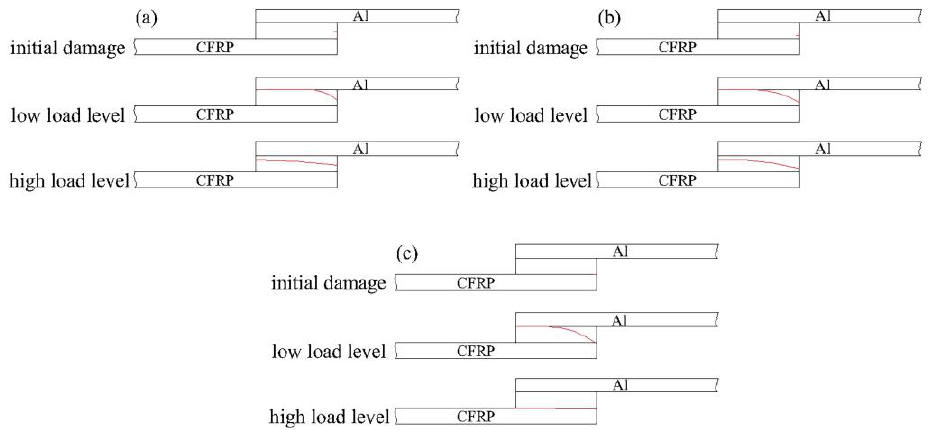
Figure 10. Cross-sections of adhesive joints: ( a ) no cyclic load applied and ( b ) cyclic load applied at 35% load level.